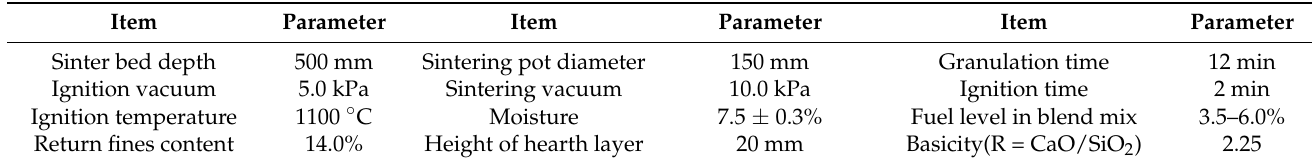
Table 3. Parameters of the sintering pot test.